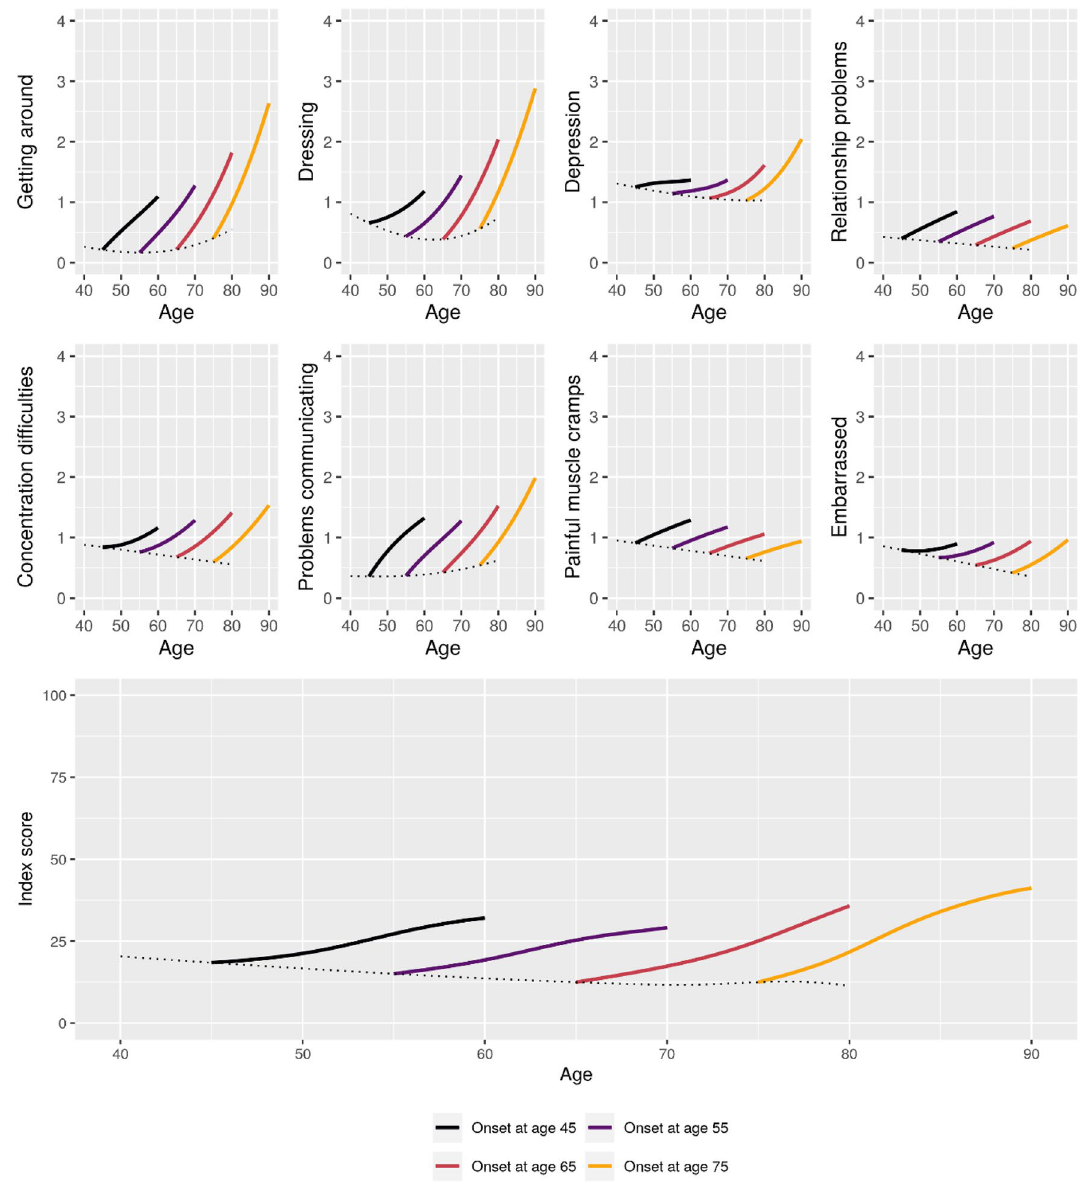
Figure 6. Estimated 15-year mean trajectories of 8-item Parkinson’s Disease Questionnaire outcomes from Parkinson’s disease onset at respectively 45, 55, 65, and 75 years of age. Trajectories estimated based on data from 2421 visits. Dotted line represents the estimated mean scores for patients with onset at the given